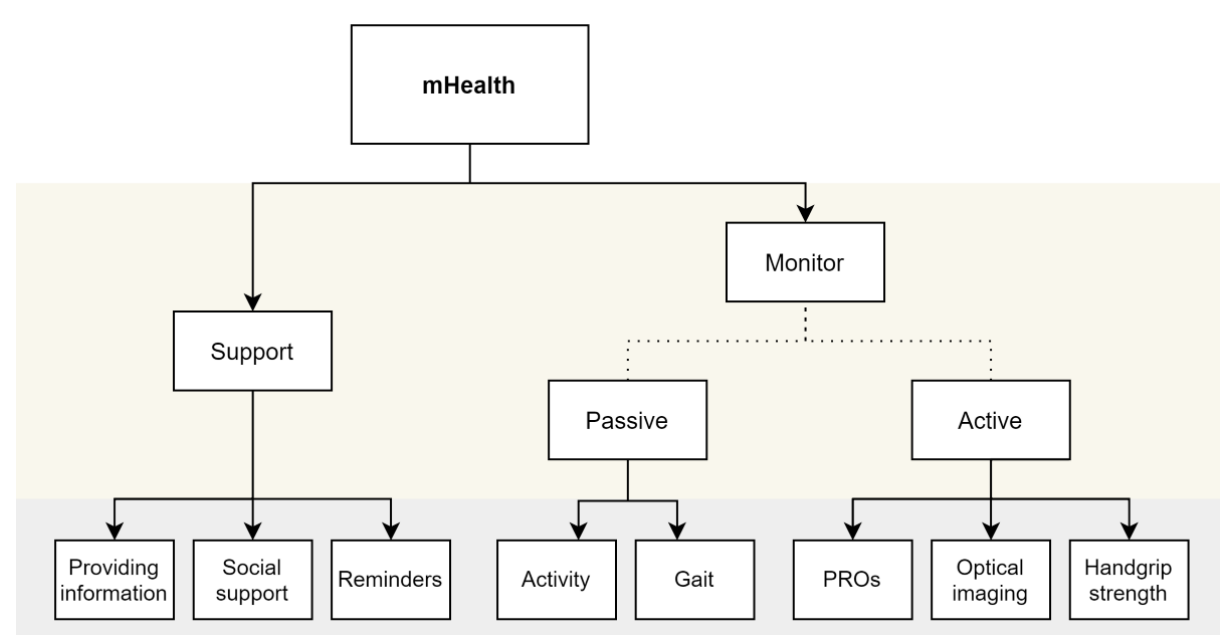
Figure 3. Identification of asynchronous mobile health (mHealth) uses in rheumatoid arthritis. PROs: patient-reported outcomes.